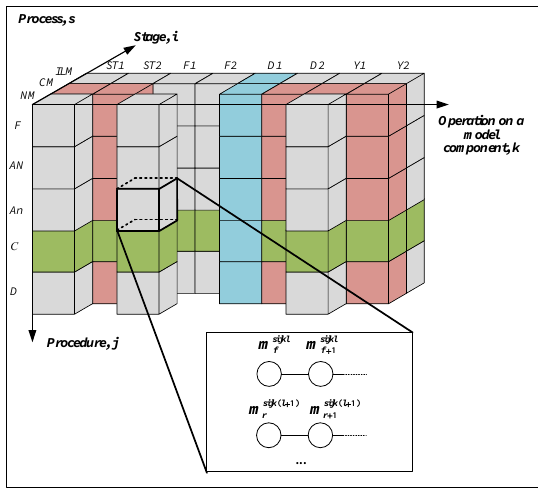
Fig 2. The structure of the visual integrated